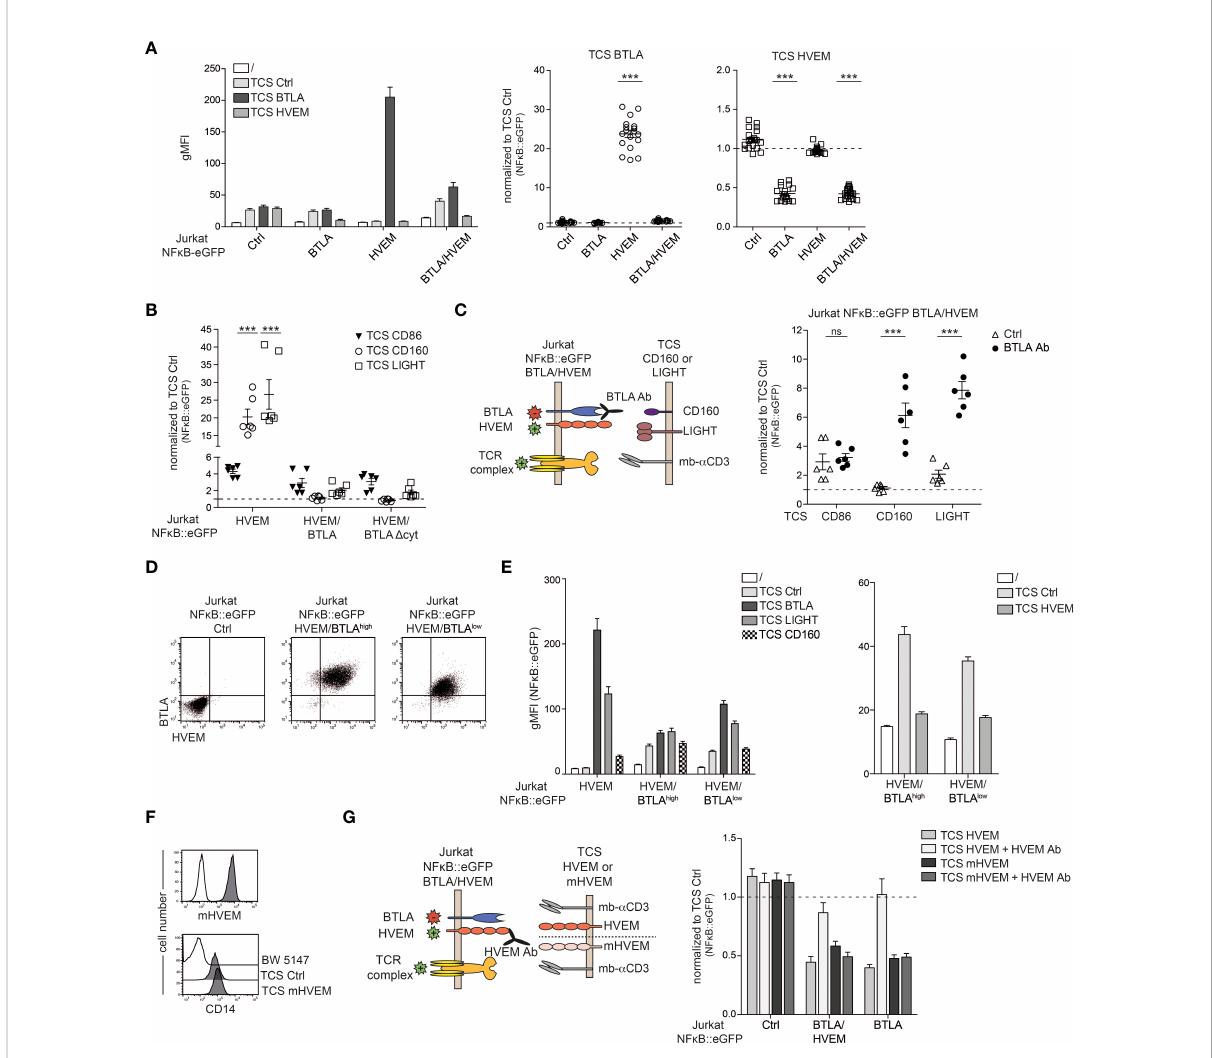
FIGURE 4 Assessment of co-expression of HVEM/BTLA signaling. (A) Control reporter cells and reporter cells expressing BTLA, HVEM or BTLA/HVEM were left unstimulated or stimulated with TCS ctrl, TCS BTLA and TCS HVEM. NF- k B::eGFP activation was measured after 24 h. Left: one representative experiment performed in duplicate is shown. Right: reporter gene expression is shown normalized to reporter gene expression induced by control-TCS (gMFI of reporter cells stimulated with the indicated TCS/gMFI of TCS ctrl stimulated cells). Data is depicted of at least eight independent experiments performed in duplicates. One-way analysis of variance followed by a Dunnett ’ s multiple comparison test were used for comparison to control reporter cells (***p ≤ 0.001; ns, p > 0.05). (B) Jurkat NF k B::eGFP ctrl and Jurkat NF k B::eGFP expressing HVEM, HVEM/BTLA or HVEM/BTLA D cyt cells were stimulated with TCS ctrl, TCS CD86, TCS CD160 and TCS LIGHT. Reporter gene expression is shown normalized to control-TCS. Results are shown from three independent experiments performed in duplicates. For statistical evaluation, two-way ANOVA followed by Bonferroni ’ s test was performed (***p ≤ 0.001). (C) Left panel: Schematic representation of receptors on reporter cells and ligands on stimulator that were evaluated in absence or presence of a blocking BTLA antibody. Right panel: Reporter cells expressing BTLA/ HVEM were stimulated with TCS CD86, TCS CD160 or TCS LIGHT in the presence or absence of a blocking BTLA antibody (5 m g/ml; clone 6F4). Reporter activation induced by the indicated TCS is shown normalized to control-TCS. Data is depicted from three independent experiments performed in duplicate. For statistical evaluation, two-way ANOVA followed by Bonferroni ’ s test was performed (***p ≤ 0.001; ns, p > 0.05). (D) Flow cytometric analysis of cell surface molecules BTLA and HVEM on the indicated reporter cells. (E) Left panel: Reporter cells expressing HVEM, HVEM/BTLA high or HVEM/BTLA low were left unstimulated or stimulated with TCS ctrl, TCS BTLA and TCS LIGHT. Right panel: Reporter cells expressing HVEM, HVEM/BTLA high or HVEM/BTLA low were left unstimulated or stimulated with TCS ctrl or TCS HVEM. gMFI of NF k B::eGFP activation is shown. Results are depicted from four independent experiments performed in duplicate. (F) Cell surface expression of mHVEM and membrane-bound anti-CD3 on TCS analysed via fl ow cytometry (open histograms: control TCS; grey histograms: expression level of the indicated molecules). (G) Left panel: Schematic representation of stimulation experiments of reporter cells co-expressing BTLA and HVEM with TCS expressing human HVEM or mouse HVEM (mHVEM) with and without HVEM antibody SL030717 (10 µg/ml) that blocks human but not mouse HVEM. Right panel: Control reporter cells and reporter cells expressing HVEM/BTLA or BTLA were stimulated with TCS HVEM or TCS mHVEM in the presence or absence of a blocking HVEM antibody. Reporter gene expression is shown normalized to control-TCS. Results are depicted from four independent experiments performed in duplicate. (A, B, C, G) ± D SD is shown. Dotted line depicts control